Question: What visual encoding does this figure use to show its data?
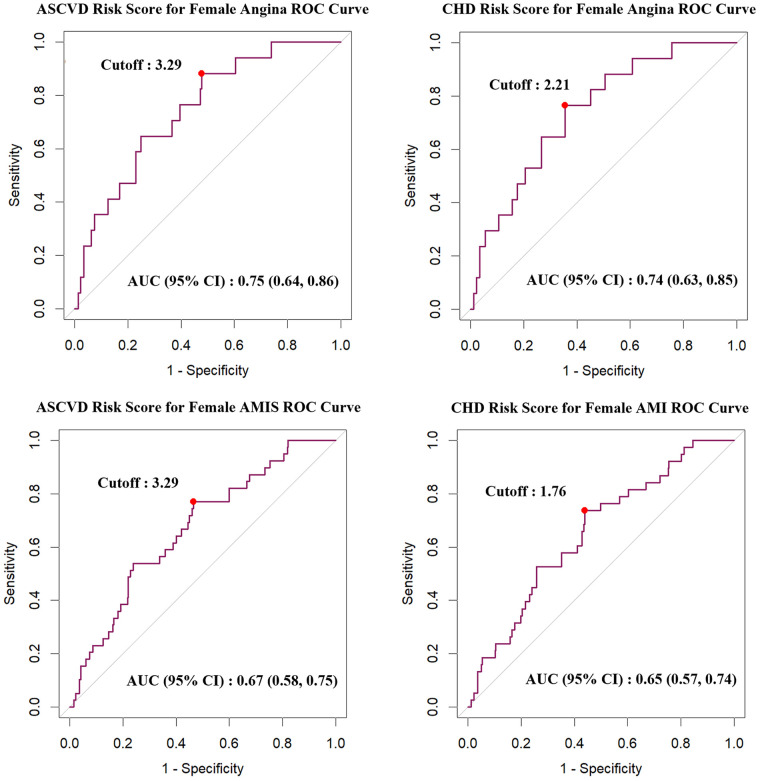
Answer: line